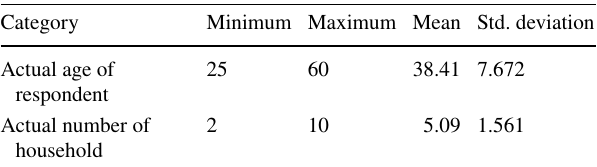
Table 3 Descriptive statistics for respondents’ age and household size